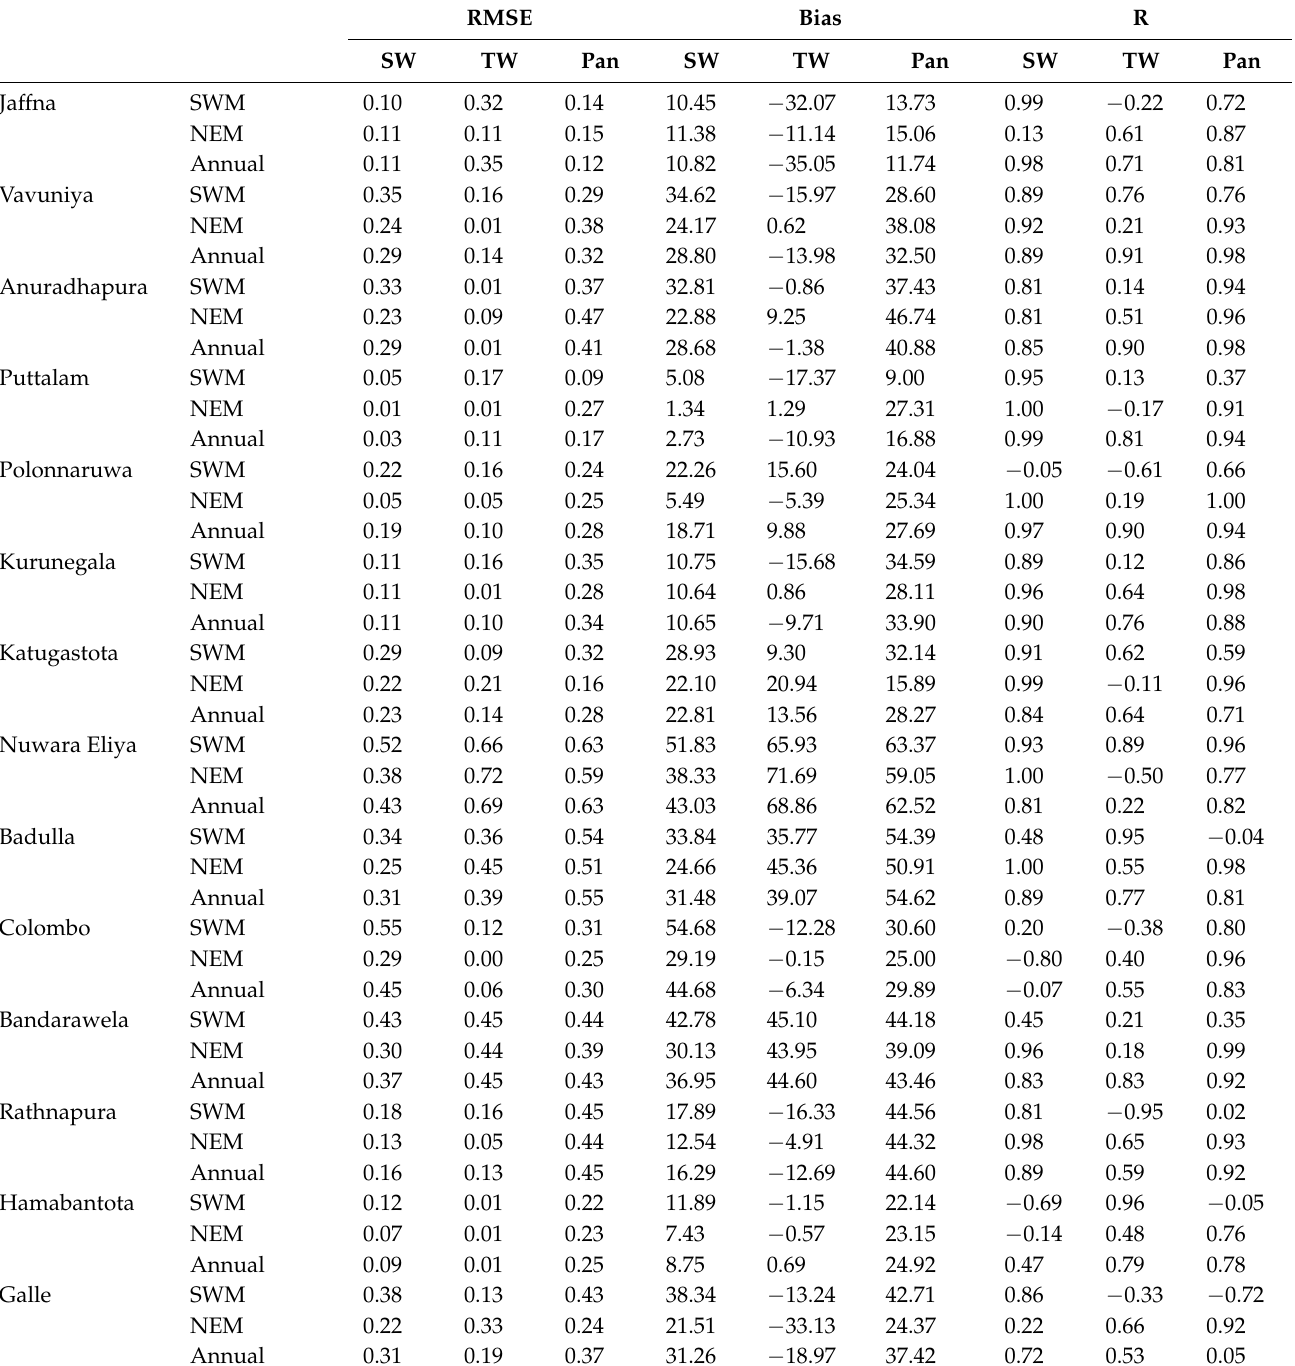
Table 4. Seasonal and annual performance indicators: RMSE, bias and R of PET estimates from S–W, TW and pan methods compared to the FAO P–M